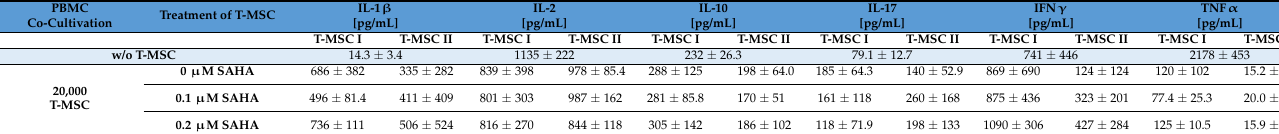
Table 2. Cytokine production of PBMC co-cultivated with SAHA-treated T-MSC . PBMC were stim- ulated with IL-2/OKT3 and co-cultivated without (w/o), with control-treated T-MSC or previously SAHA-treated T-MSC. Supernatants of co-cultures were analyzed after 48 h. The cytokine levels were determined by Multiplex analyses. T-MSC of two different sources were used (T-MSC I and T-MSC II). PBMC of two different healthy donors were co-cultivated with each T-MSC in two separate experiments. Data show mean ± SD, n = 4. PBMC: peripheral blood mononuclear cell; T-MSC: tumor-derived mesenchymal stromal cell; IL: interleukin; IFN γ : interferon gamma; TNF α : tumor necrosis factor alpha; SAHA: suberoylanilide hydroxamic acid.